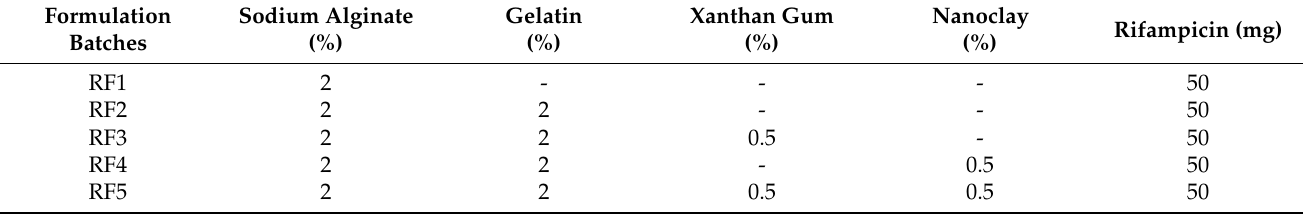
Table 1. Formulation composition of rifampicin biocomposite